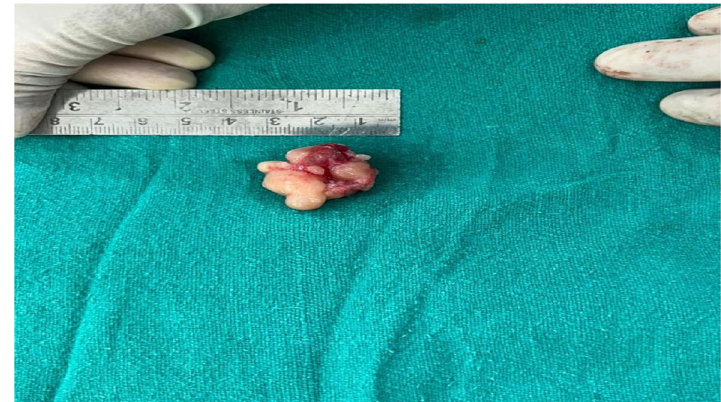
magnification (Verocay body at center ×